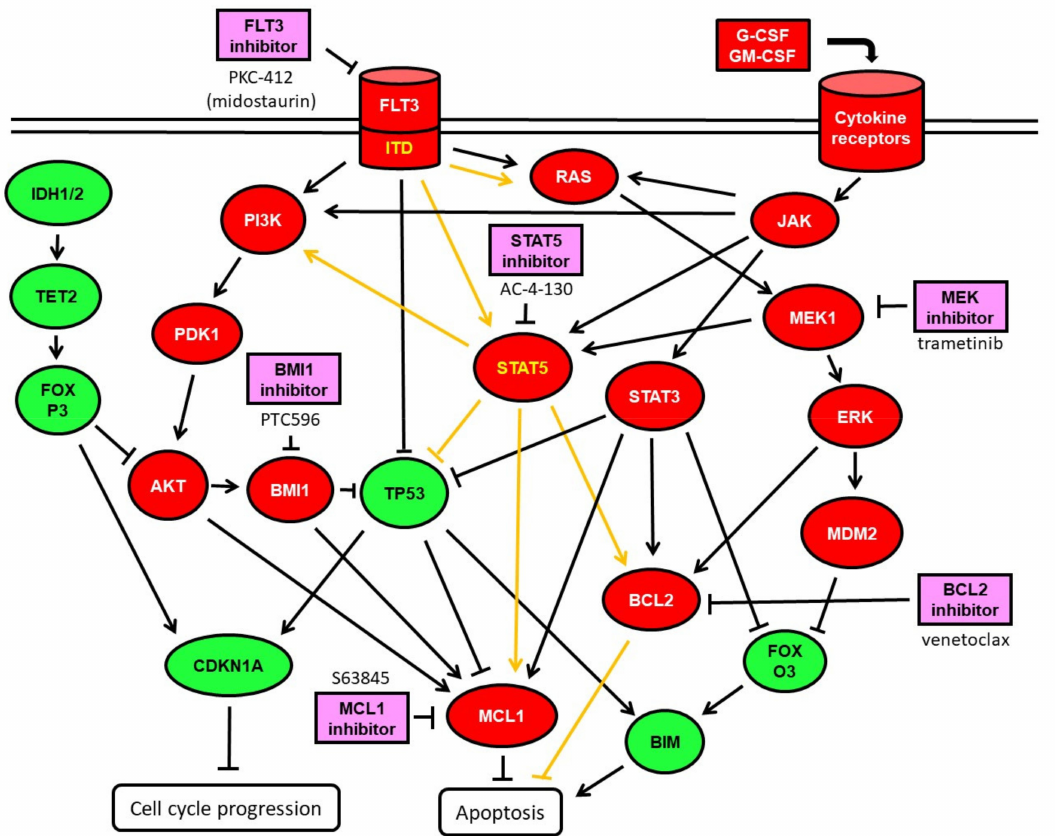
Figure 2. Schematic representation of STAT5 signaling pathways in myeloid cells. STAT5 can be activated by FLT3-ITD and by cytokine receptor signaling via Janus tyrosine kinases (JAKs). FLT3-ITD is a constitutively active growth factor receptor signaling via PI3K-AKT [2], via RAS-MEK-ERK [3], and via STAT5 [16], leading to cell growth and proliferation via p53 inhibition and MCL1 induction. Hematopoietic cytokine receptor signaling is largely mediated by JAKs and their downstream transcription factors, the STATs [7]. Mutations in the tumor suppressors IDH1/2 and TET2 may be functionally equivalent [21]. The tumor suppressor FoxP3 may inhibit AKT and its downstream target MCL-1 [22,23]. Oncogenic functions are indicated in red, tumor suppressor functions in green, and chemical inhibitors in